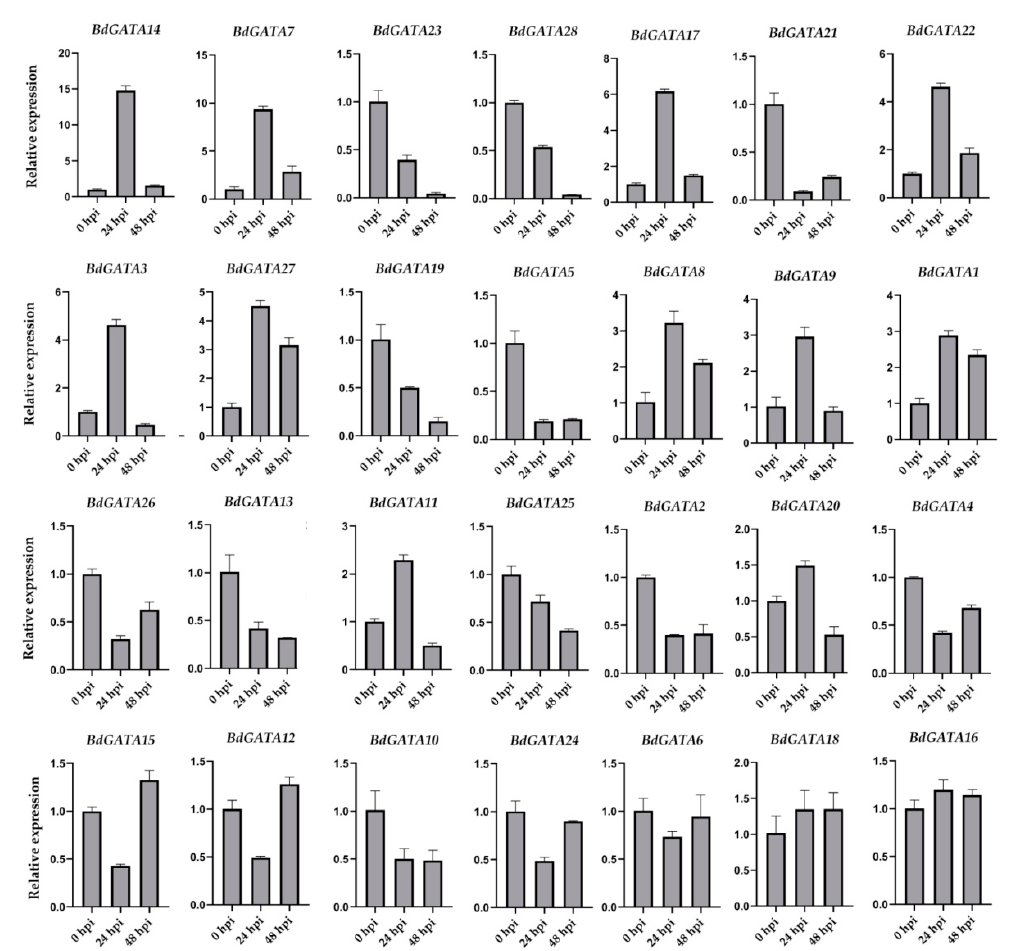
Figure 8. Expression of BdGATA genes inoculated with Magnaporthe oryzae . The relative expression levels of BdGATA genes were normalized with BdUBC . The experiments in all panels were repeated three times with similar results.